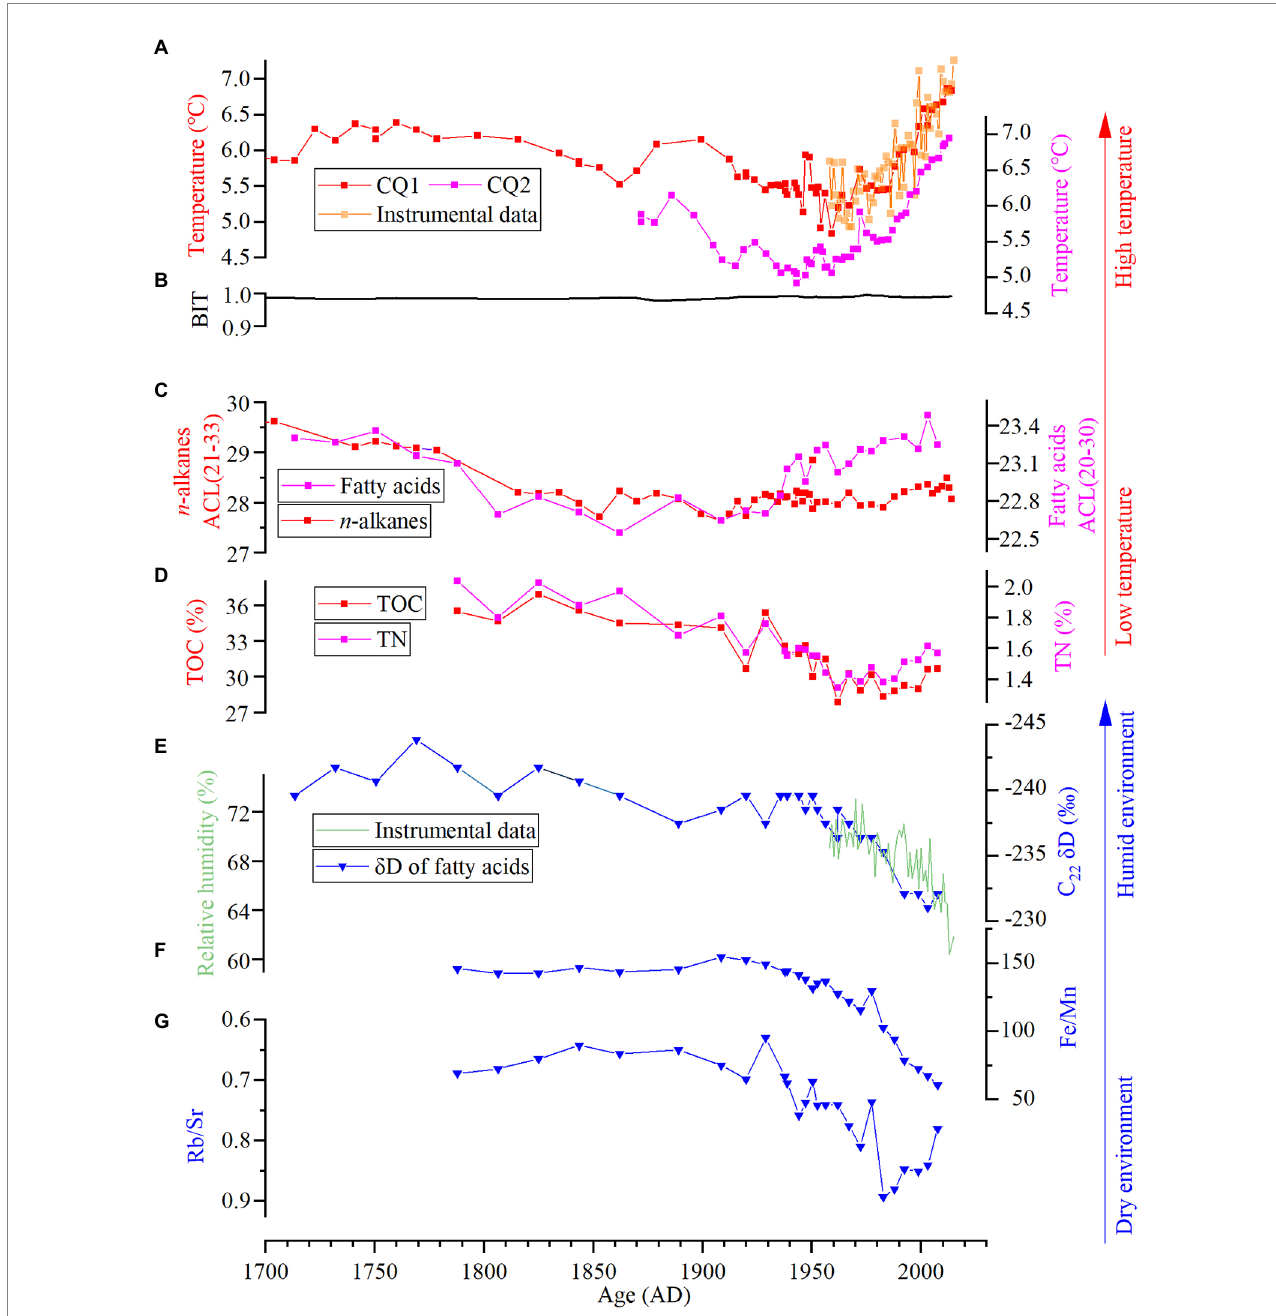
FIGURE 2 Results of multiple proxies from Lake Cuoqia. (A) The reconstructed temperature using brGDGTs from core CQ1 (red line) and CQ2 (magenta line). The orange line represents the warm season temperature (3–10 month) from Shangri La Meteorological Station. Elevation correlation was made using a lapse rate of ~0.53 ° C/100 m (He and Wang, 2020). (B) BIT values. (C) ACL values of fatty acids and n -alkanes. (D) TOC and TN (Chai et al., 2018). (E) δ D of fatty acids (C 22 , blue line) and relative humidity (green line) from instrumental data. (F) Fe/Mn ratio. (G) Rb/Sr. ratio. (For interpretation of the references to color in this figure legend, the reader is referred to the web version of this